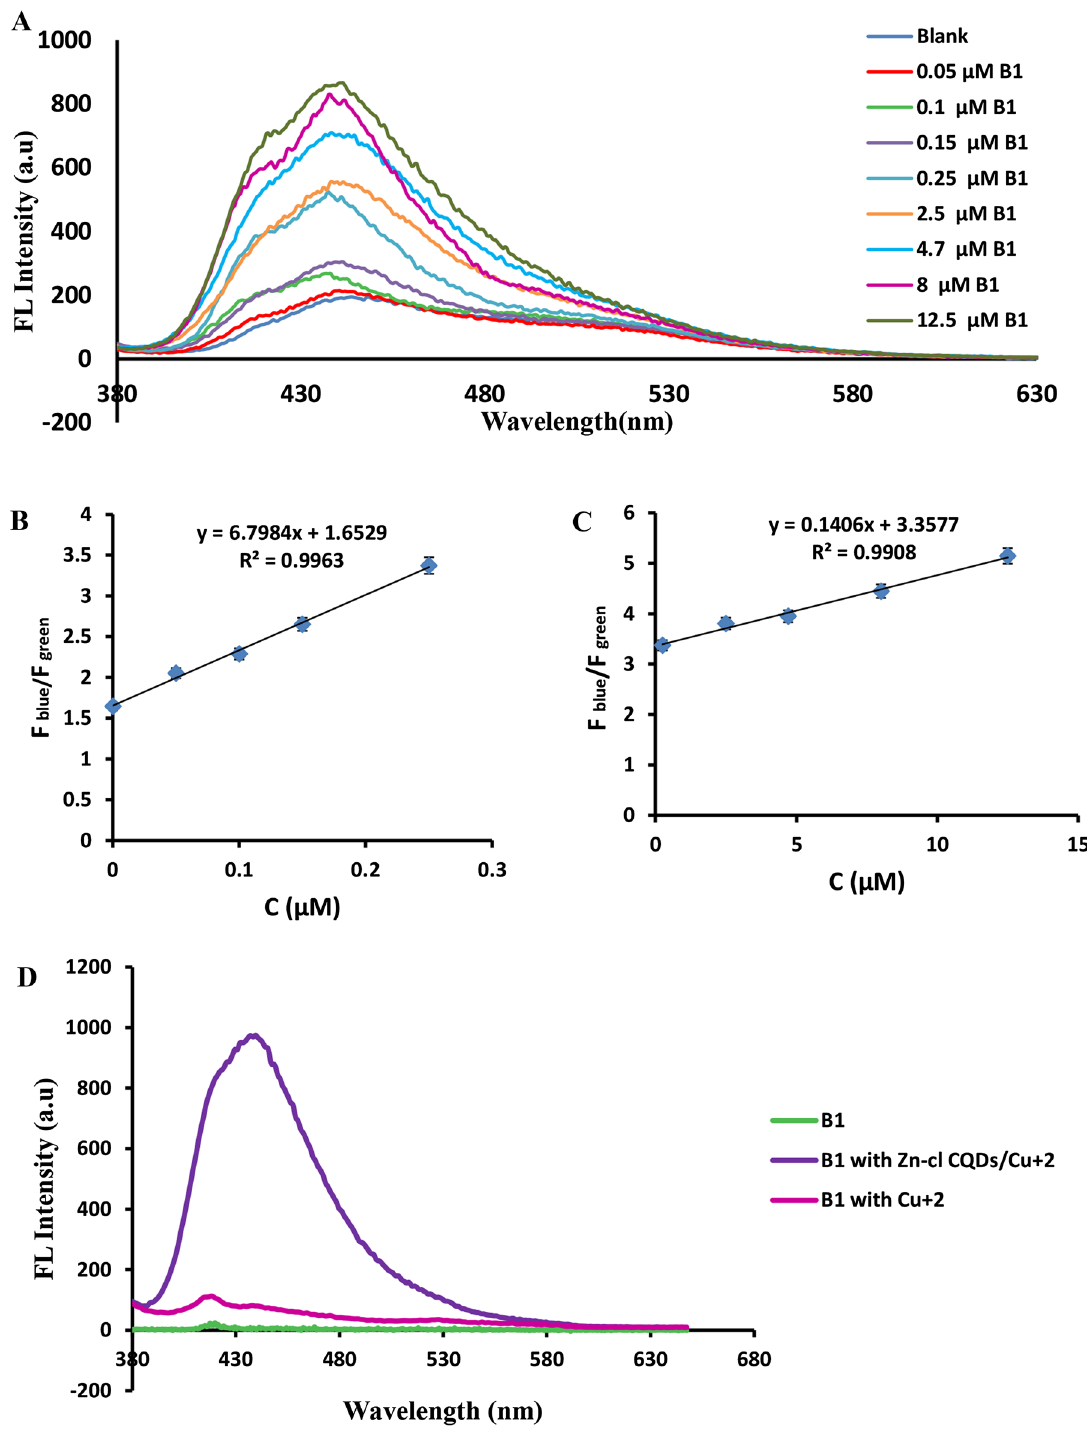
Figure 4. ( A ) The ratio of the relative fluorescence signal of blue to green emission peaks (F blue /F green ) upon successive addition of thiamine. ( B,C ) Linear regression graph of F blue /F green values against thiamine concentration in two linear ranges of 0.05–0.25 μM and 0.25–12.5 μM. ( D ) The fluorescence spectra of pure thiamine in the presence and absence of Cu 2+ ion and